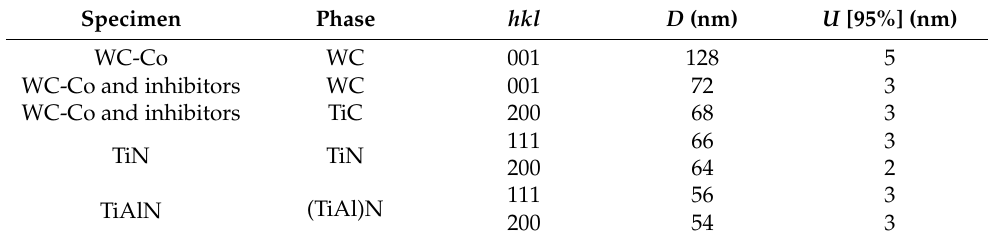
Table 4. The average crystallite sizes, their measurement uncertainties, and supported data.